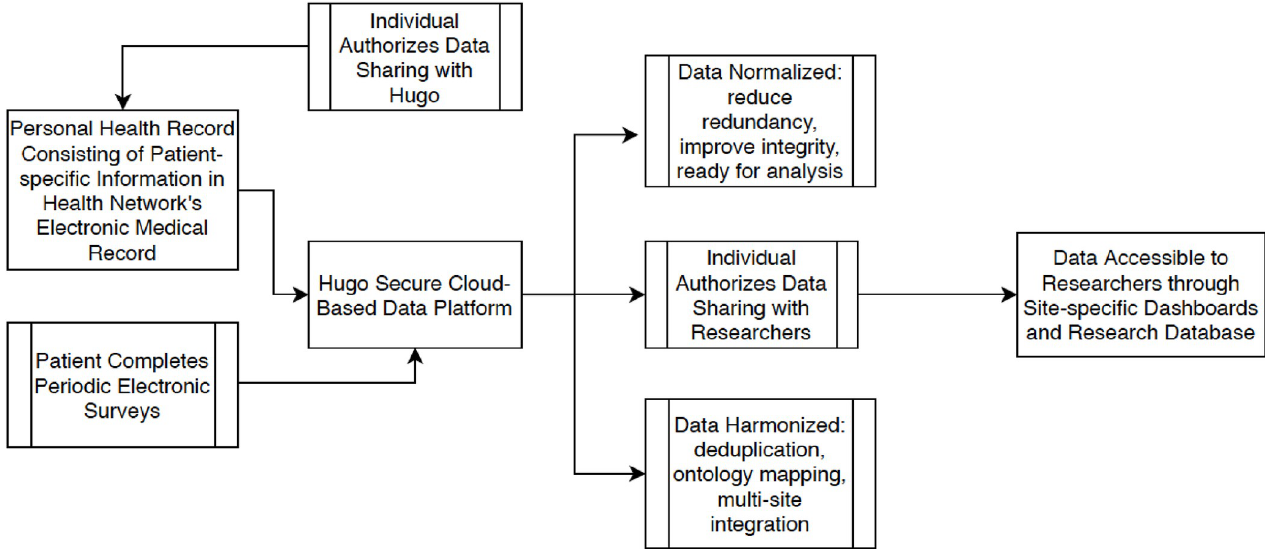
Fig 2. Use of Hugo health to capture participant